Question: Briefly state, in one sentence, what is plotted here.
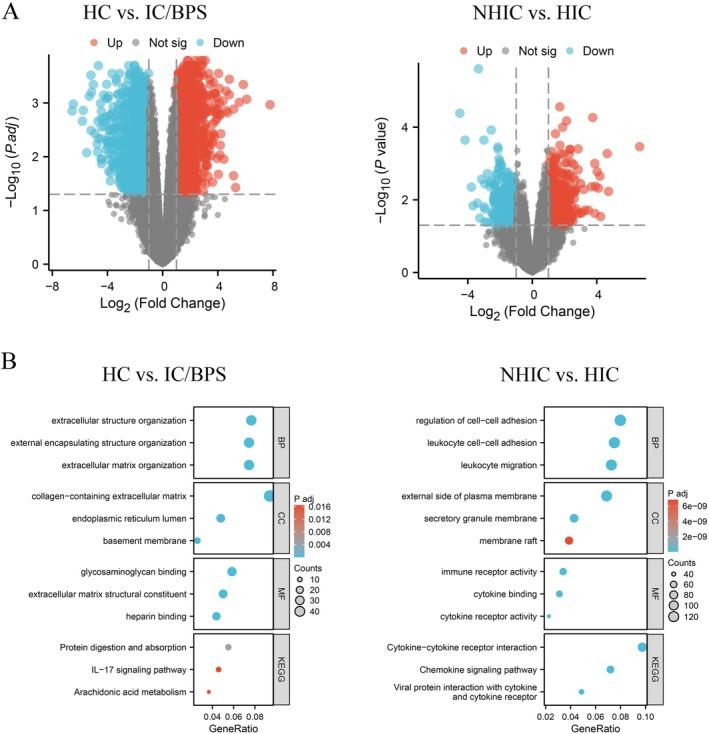
Answer: Transcriptomic profiling and functional enrichment analysis in IC/BPS and its subtypes. (A) Volcano plots showing DEGs in HC versus IC/BPS (left) and NHIC versus HIC (right) cohorts. The X‐axis shows log 2 ‐transformed fold change (log 2 FC), and the Y‐axis shows −log 10 ‐transformed adjusted p ‐values. Red and blue dots represent significantly upregulated and downregulated genes, respectively; gray dots indicate non‐significant genes. Dashed lines denote the significance thresholds (|log 2 FC| ≥ 1, adjusted p < 0.05). (B) Functional enrichment analysis of DEGs, including GO terms and KEGG pathways.